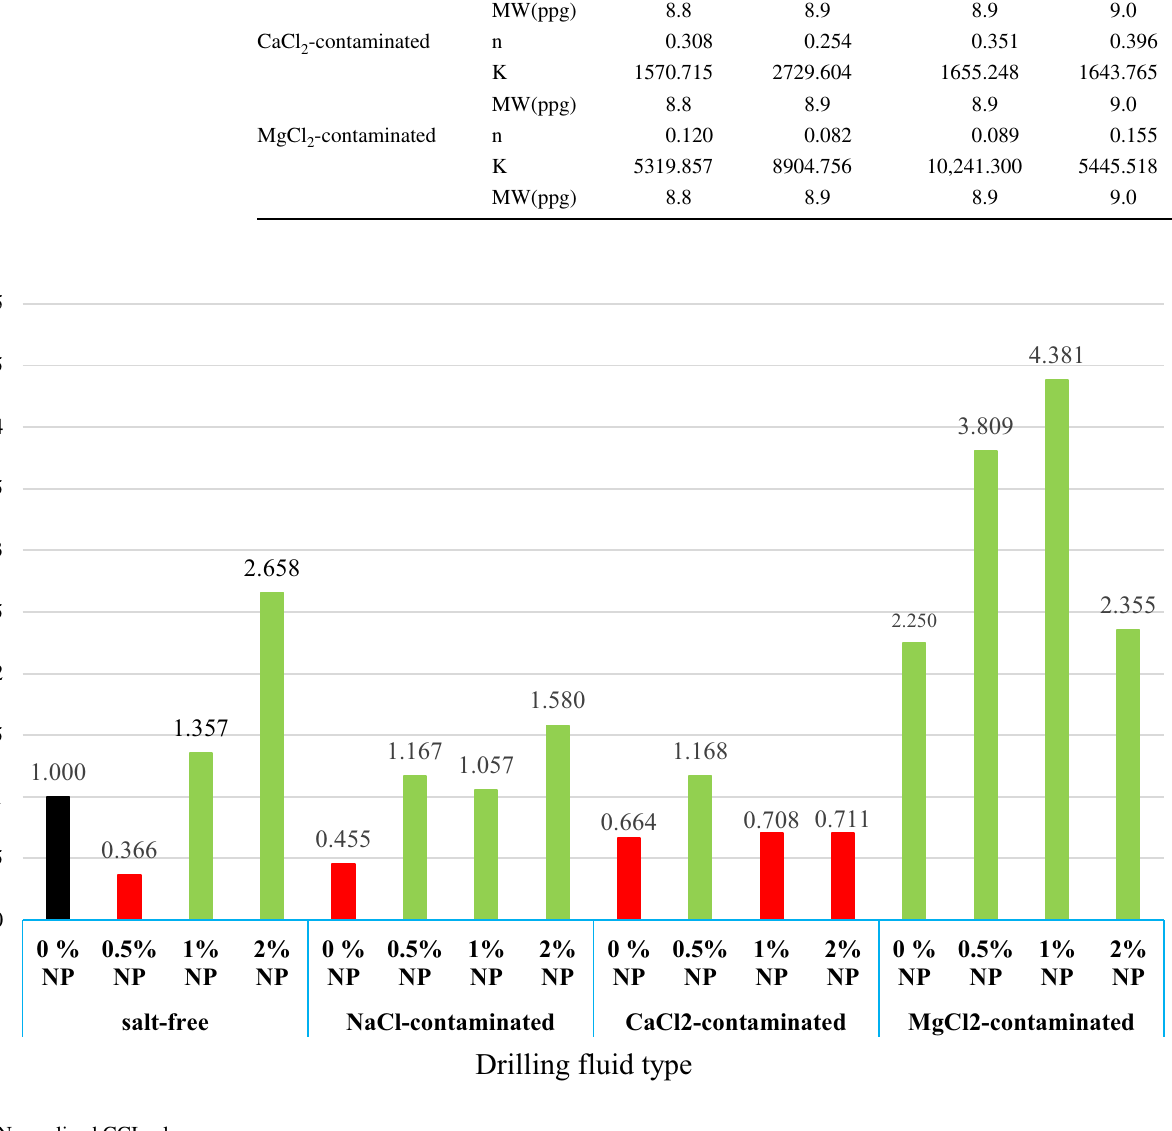
Fig. 4 Normalized CCI